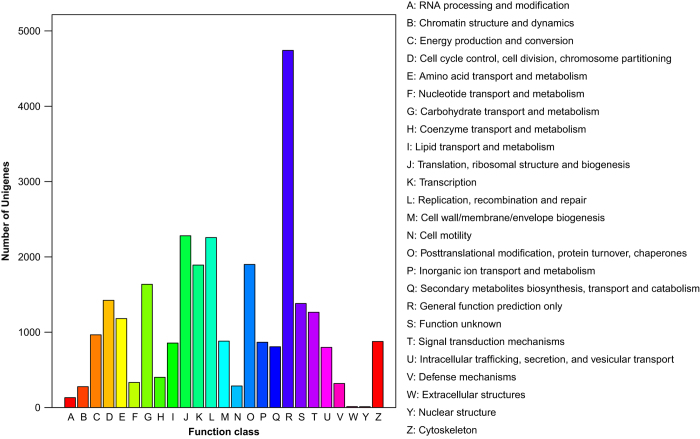
COG functional classification of the Henosepilachna vigintioctopunctata transcriptome.